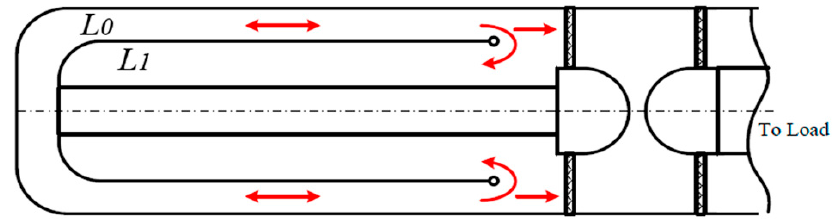
Figure 3. Double width forming line.